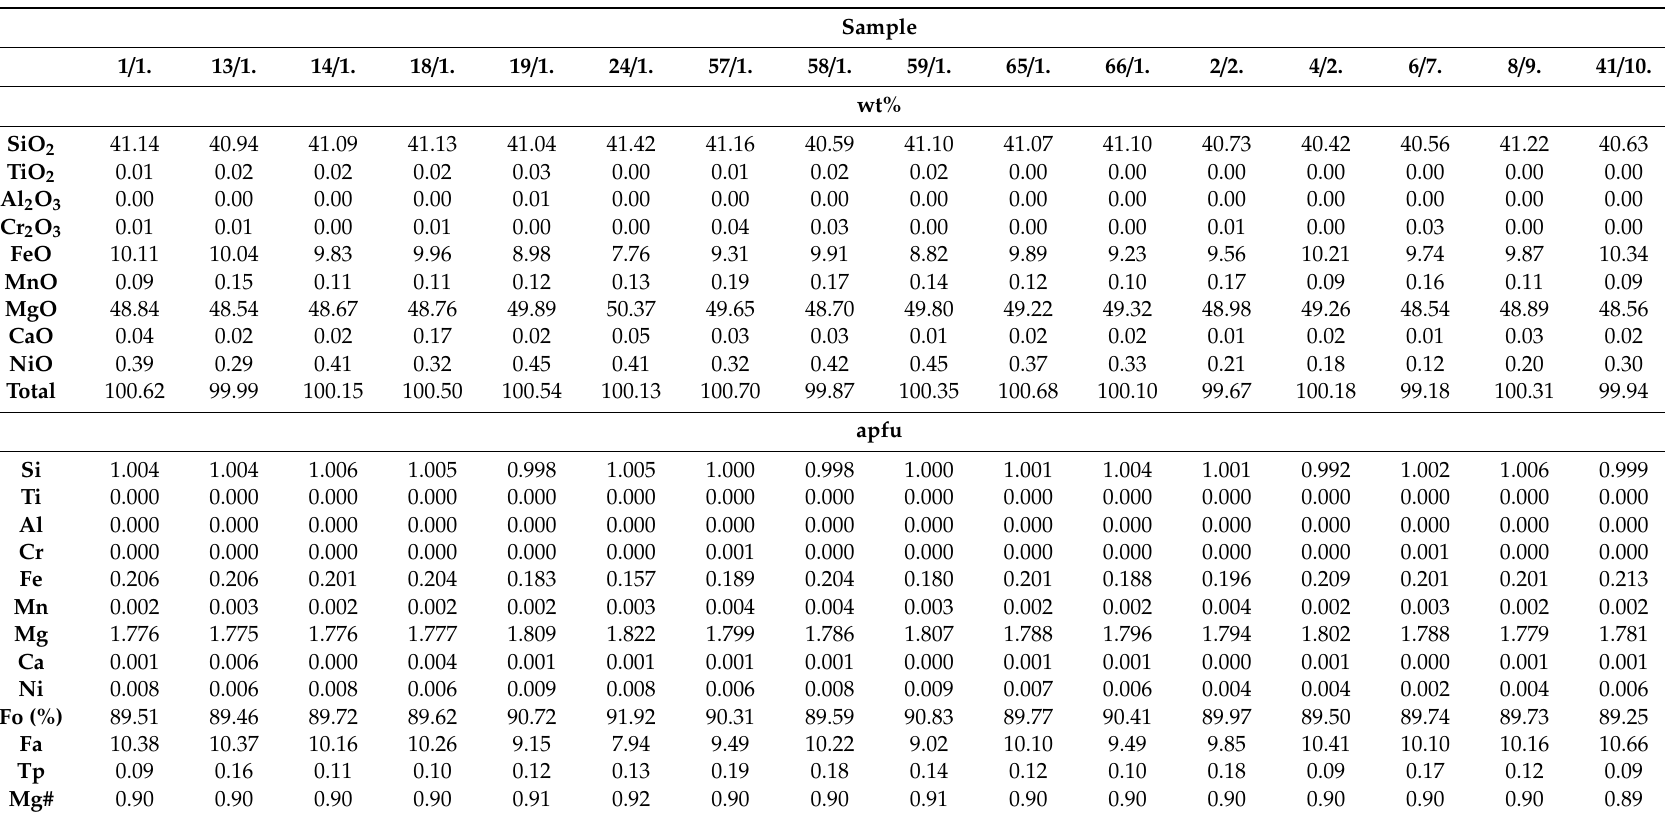
Table 6. Chemical composition of olivine in wt%. EPMA